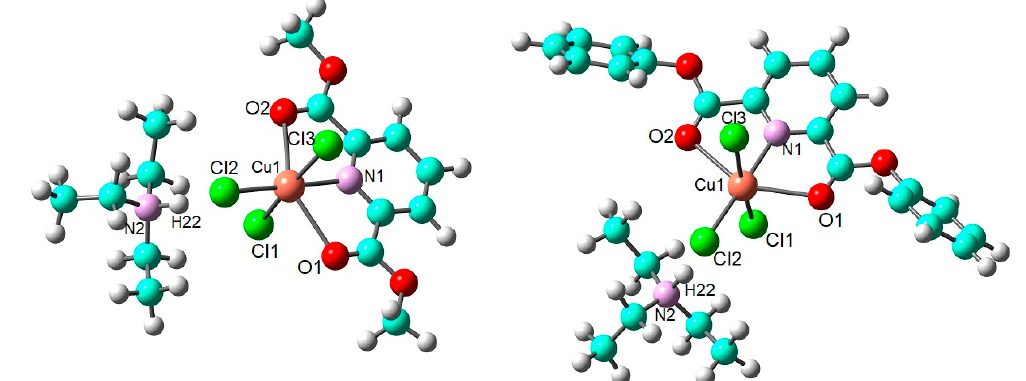
Figure 4. DFT-calculated geometry-optimized (B3LYP/6–31+G(d,p), Gaussian) structures of (HNEt 3 )[Cu(pydicMe 2 )Cl 3 ] and (HNEt 3 )[Cu(pydicPh 2 )Cl 3 ] in the gas phase with numbering. In CH 2 Cl 2 , acetone, DMF, and MeCN solution, the geometry of the complexes remains rather intact. Only the Cu ‒ Cl3 bond is markedly elongated with a slight tendency of longer bonds for more polar solvents along this series. Even more pronounced is the increasing distance between the ions due to the shielding of electrostatic interactions in these solutions (see Tables S3–S7 in the